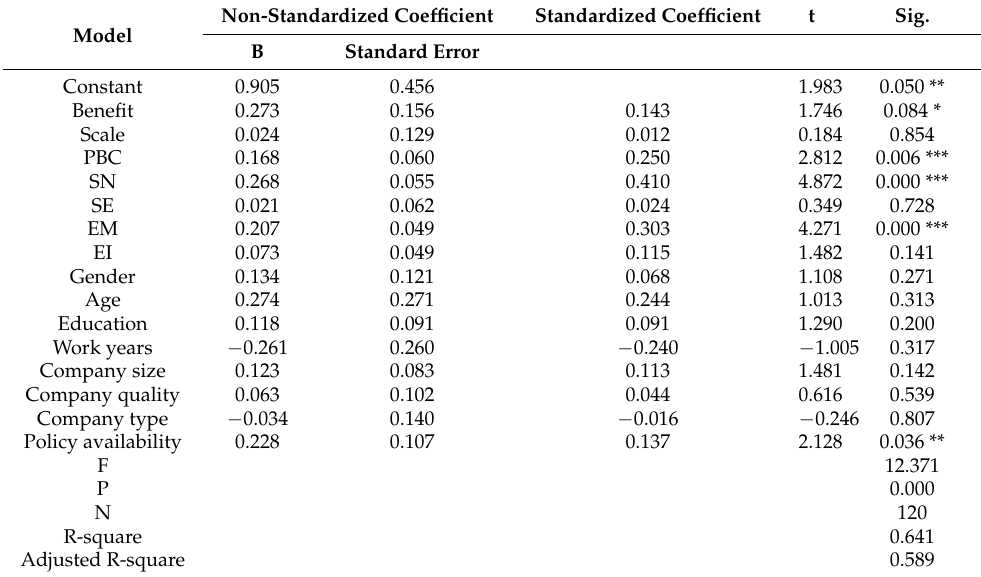
Table 7. Regression on behavior intention regarding